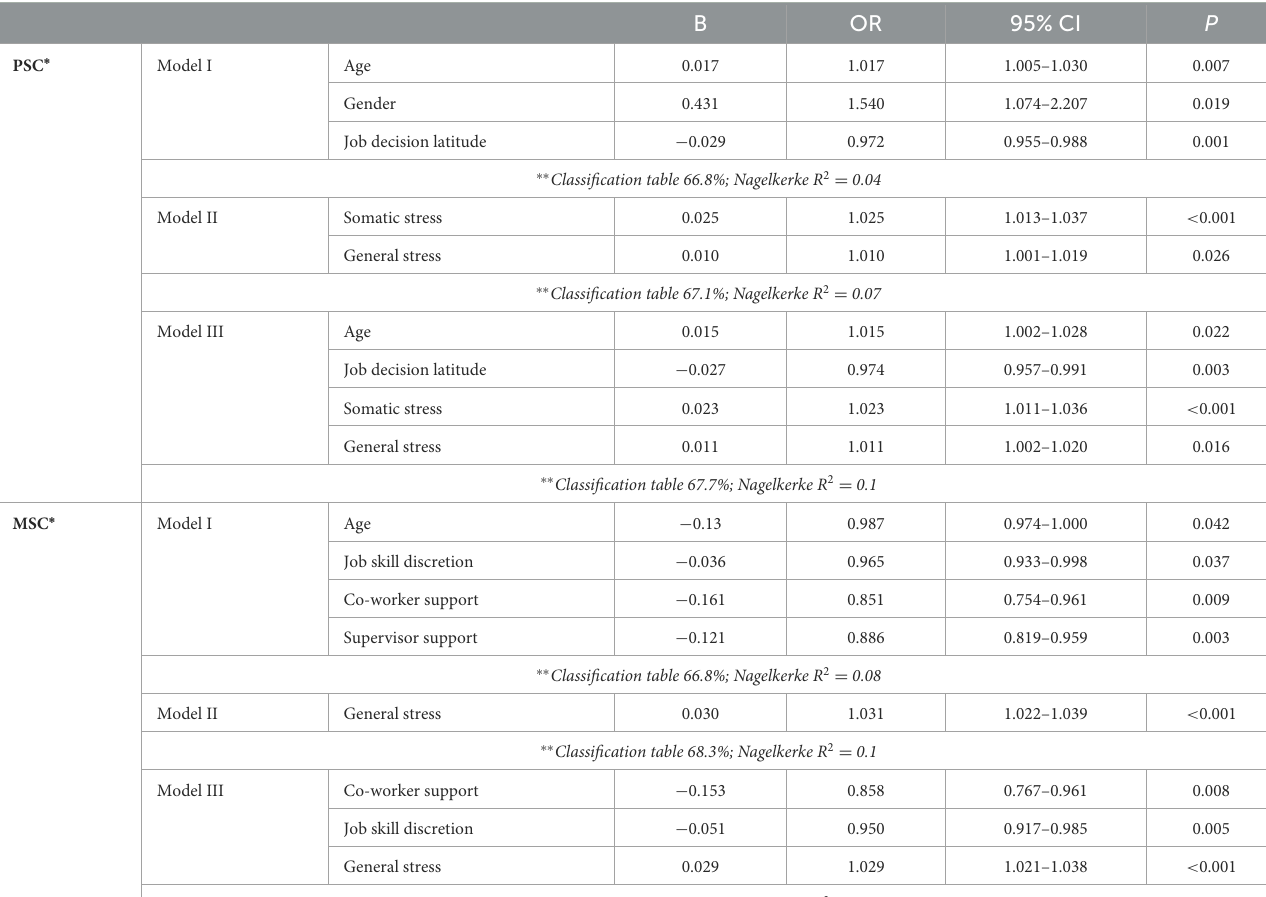
∗∗ Classification table 70.5%; Nagelkerke R 2 =